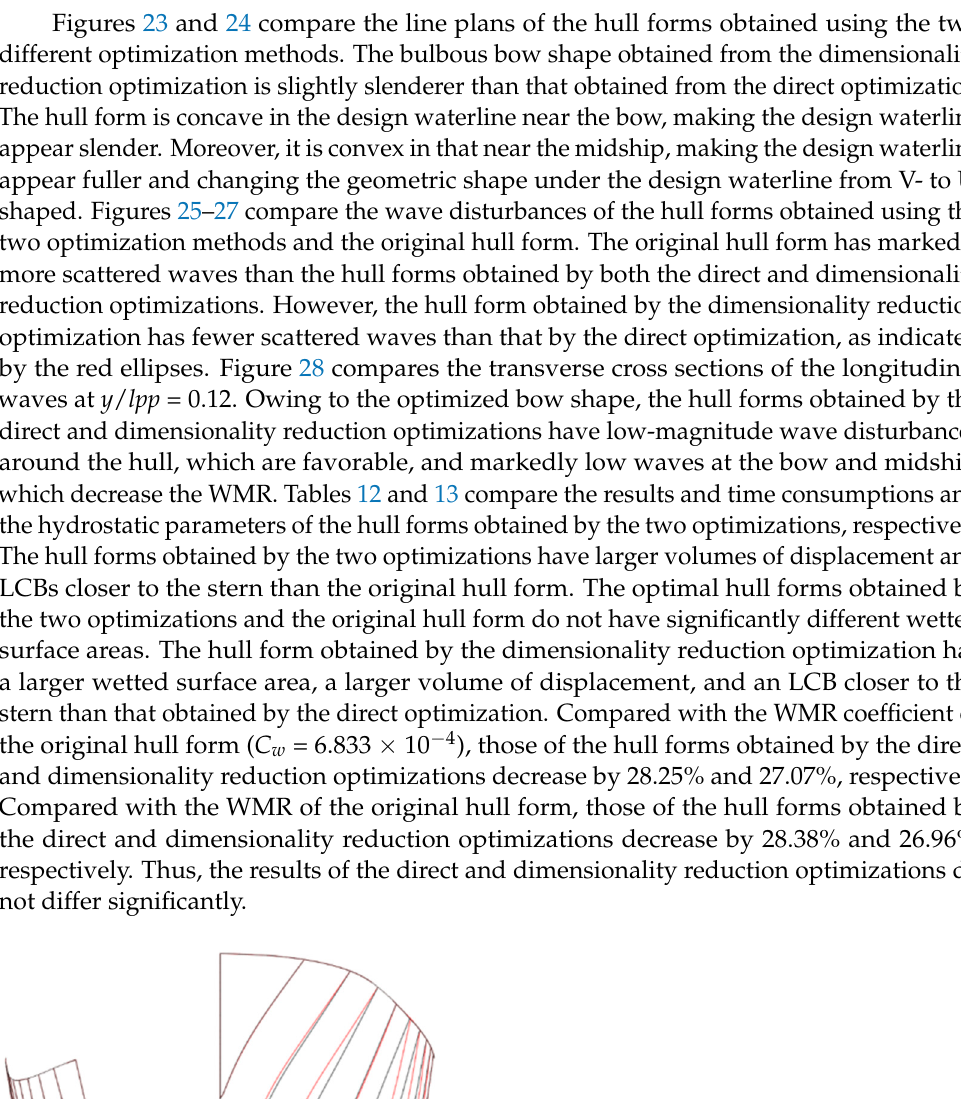
Figure 24. Comparison of profile views of hull forms obtained by direct and dimensionality reduc- tion optimizations. Figure 25. Comparison of wave disturbances of original hull form and hull form obtained by direct optimization.